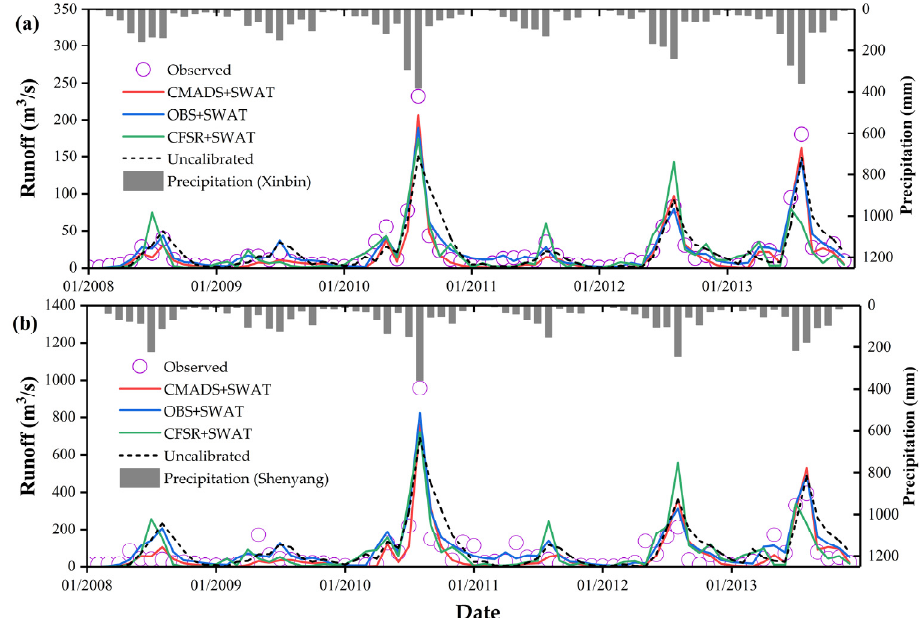
Figure 6. Observed monthly runoff and SWAT model simulations at the hydrological stations during the calibration period (2008–2010) and validation period (2011–2013); ( a ) Beikouqian station, ( b ) Shenyang station.